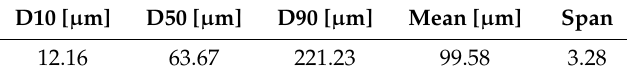
Table 3. Size parameters of wood fibers.